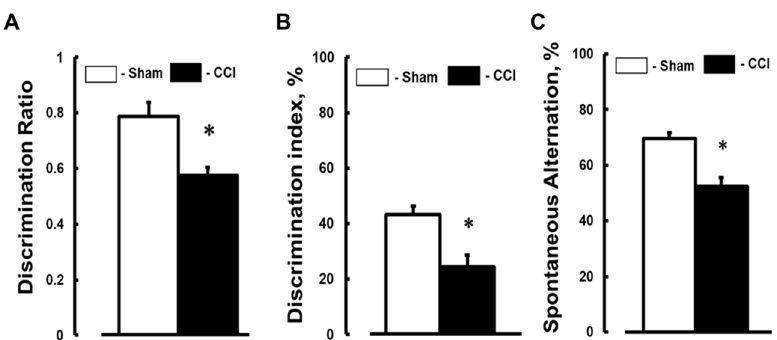
Figure 4. Short-term memory reduction 14 days after cortical contusion injury (CCI) in mice. Results of mice’s short-term memory assessed by ( A ) a novel object recognition test (NORT), and Y-maze ( B ) two trial recognition and ( C ) spontaneous alternation tests. * p < 0.05 vs. Sham. n = 16.